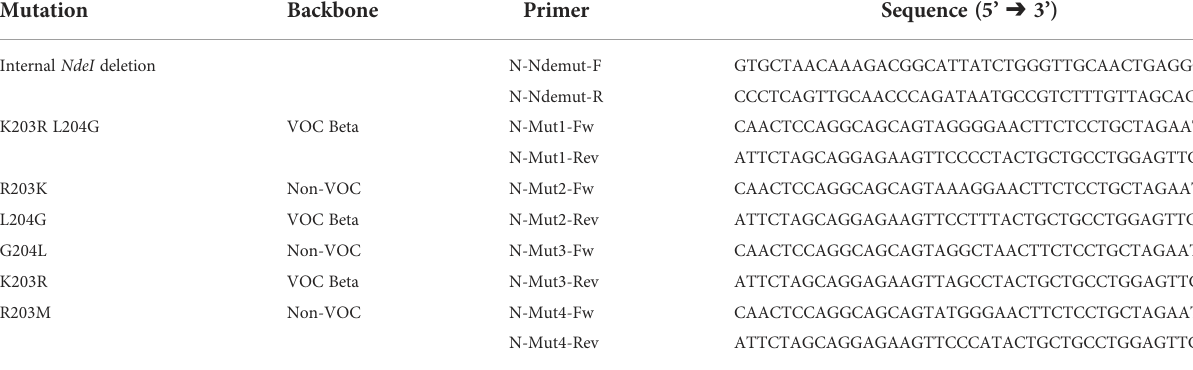
TABLE 2 Primer used for PCR